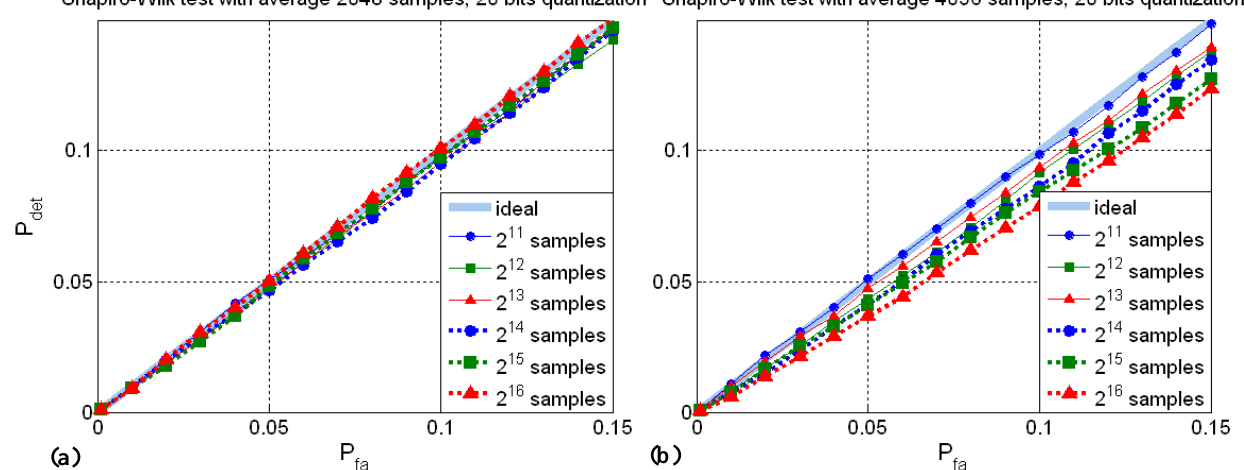
Figure 1. Comparison between the performance of Shapiro-Wilk test with block size set of 2,048 (Figure 1a) and 4,096 (Figure 1b). 20 quantization bits have been used to neglect quantization errors. For 4,096 samples (>2,000 [23]) the performance degrades, while does not for 2,048 samples.